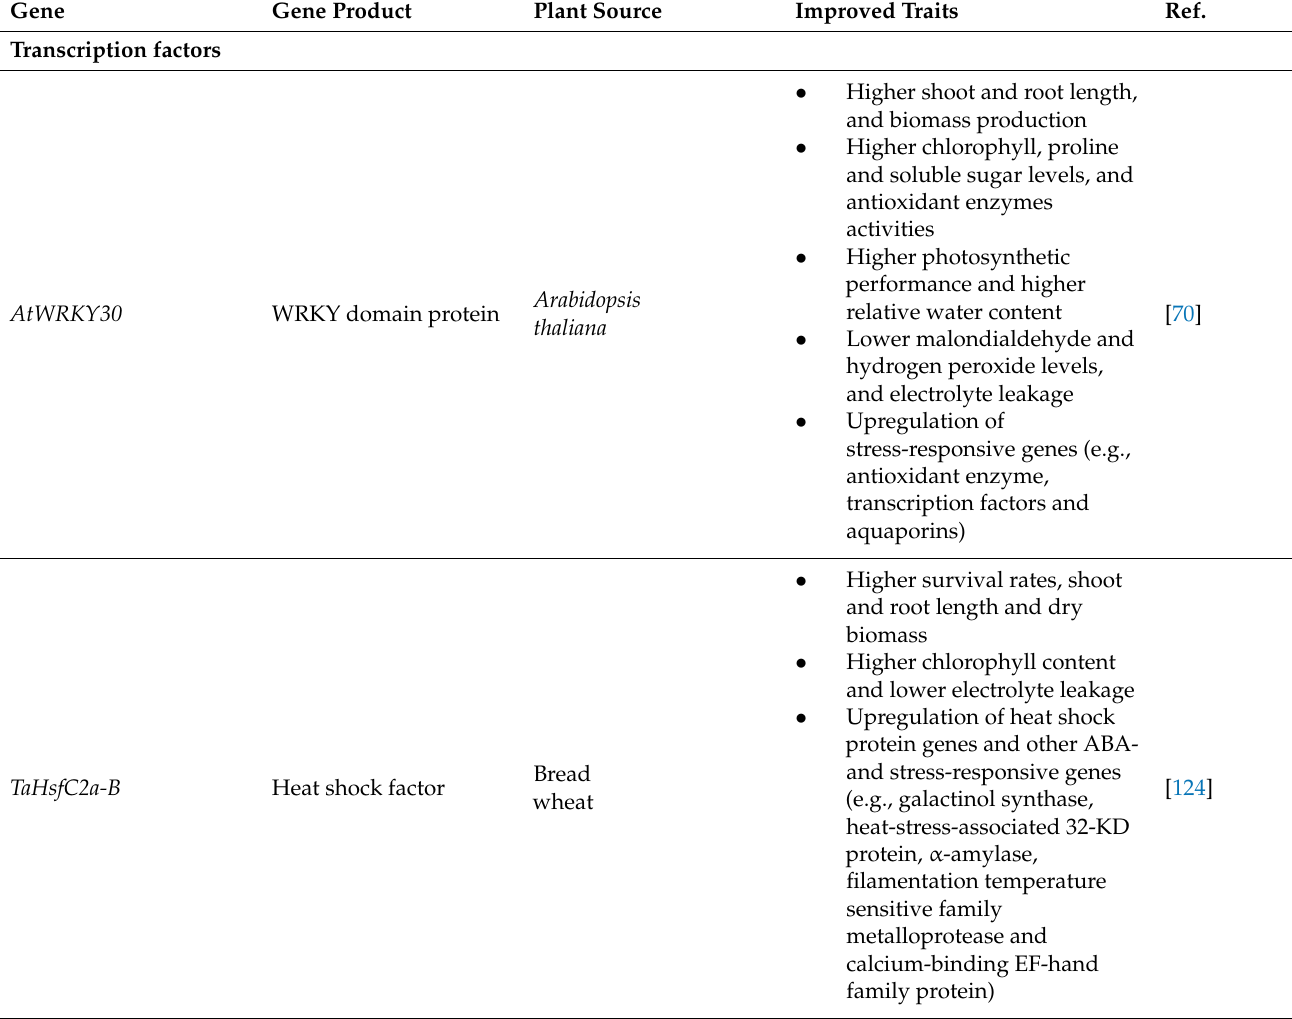
Table 3. Improvement of heat tolerance in wheat plants through transgenic approaches. Gene Gene Product Plant Source Improved Traits